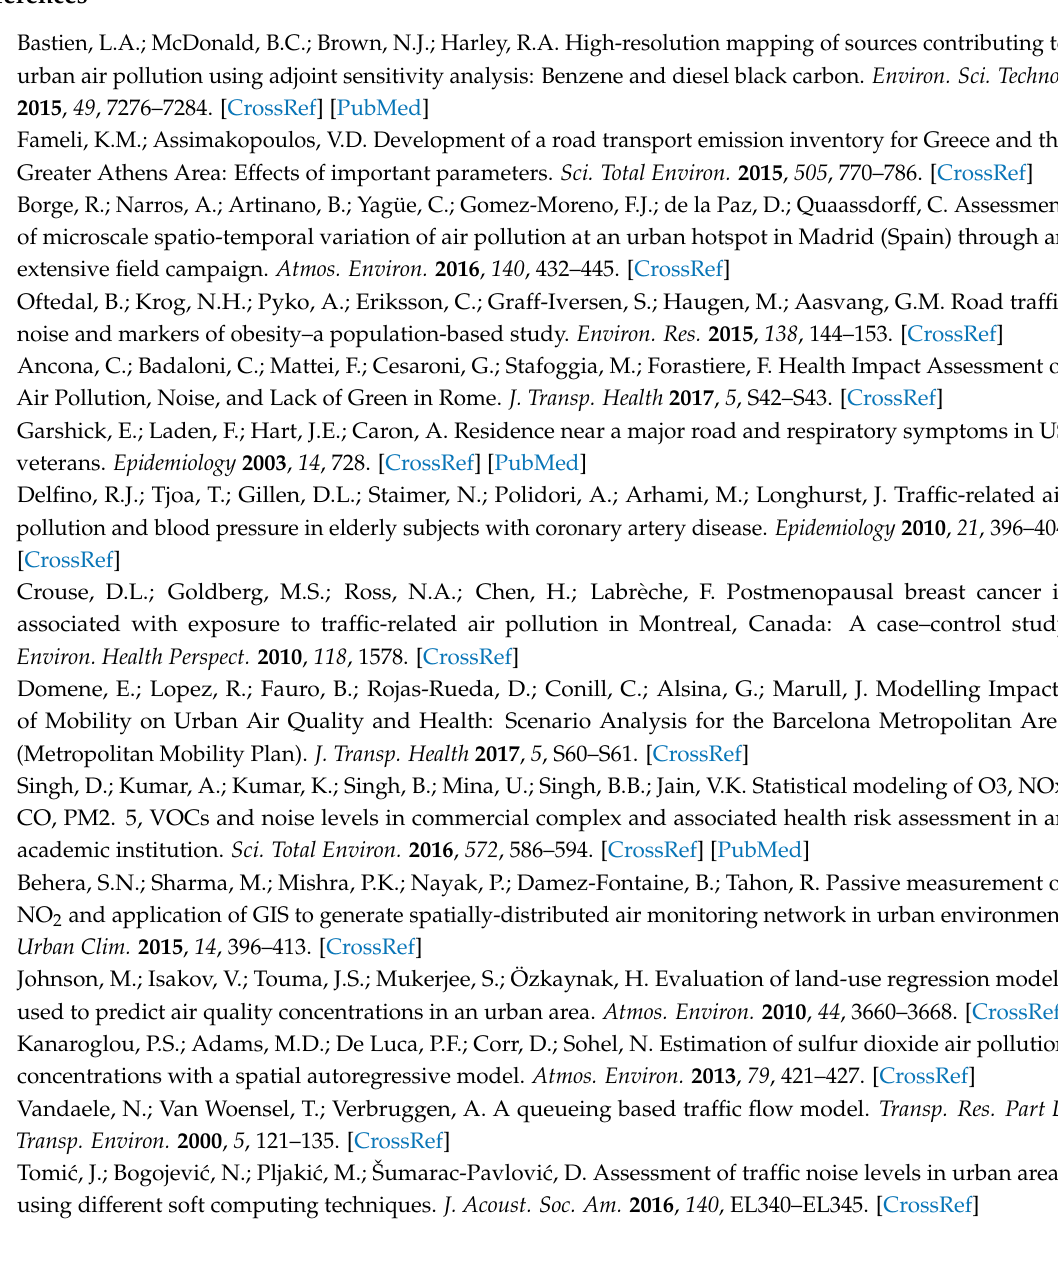
An Artificial Neural Network is a computational model based on the structure and functions of biological neural networks. Information that flows through the network affects the structure of the ANN because a neural network changes—or learns, in a sense—based on that input and